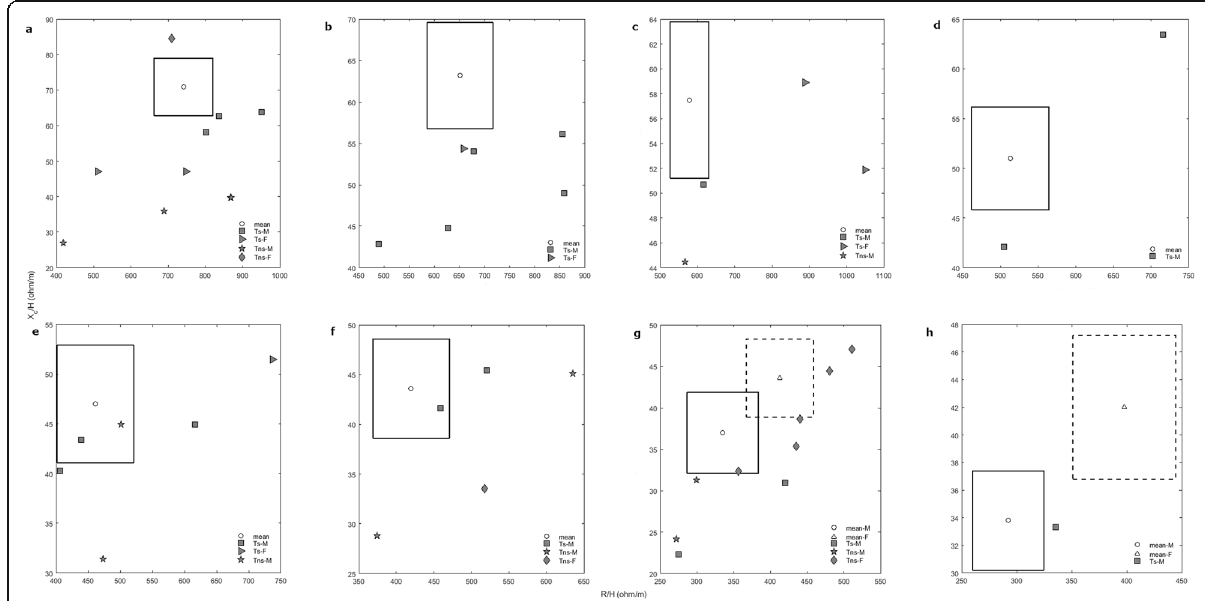
Fig. 1 Xc/H versus R/H plot for apparently healthy and cancer children for ( a ) 2 – 3 years, ( b ) 4 – 5 years, ( c ) 6 – 7 years, ( d ) 8 – 9 years, ( e ) 10 – 11 years, ( f ) 12 years, ( g ) 13 – 16 years and ( h ) 17 – 59 years. The height of the patient was represented by H. Each reference rectangle was done by mean ± 2 standard deviation reported in [16] (displayed in Table 1, courtesy of MSc. Alcibiade Lara Lafargue and Centro Nacional de Electromagnetismo Aplicado) and delimited with continuous line (for male) and discontinuous line (for female). Average values for male and female were represented by the circle and the unfilled triangle, respectively. The body bioelectric state of each cancer child was displayed: male child with solid tumor (Ts-M or filled square), non-solid male child (Tns-M or filled star), female child with solid tumor (Ts-F or filled triangle) and non-solid female child (Tns-F or filled